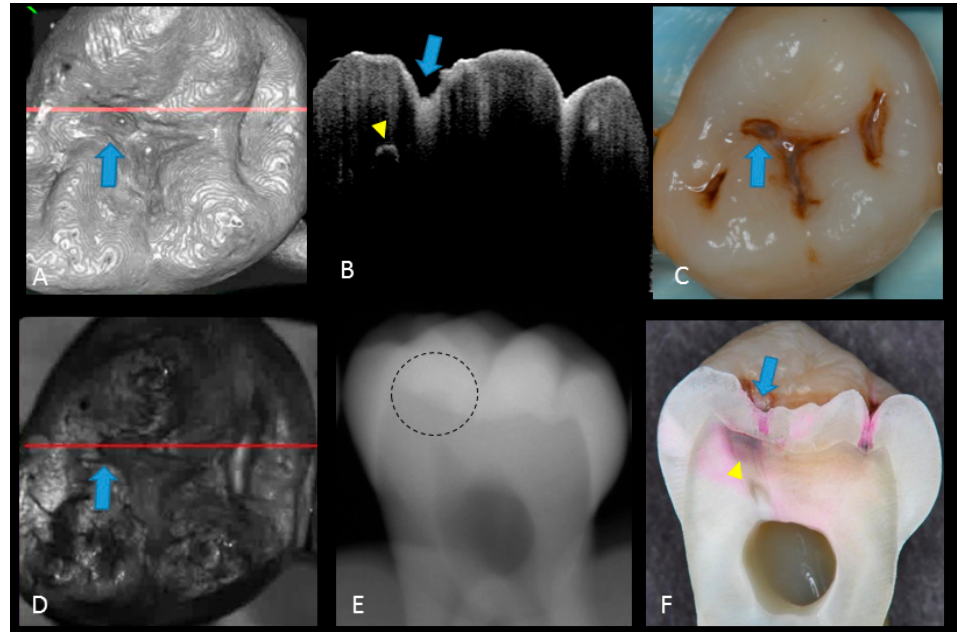
Figure 6. Dentin caries: ( A ) gray-scale three-dimensional (3D) OCT image; ( B ) cross-sectional OCT image of the lesion along the red line in (A) and (D). A separation of DEJ (triangle) was observed at the bottom at the lesion (arrow) indicating the lateral invasion of bacteria; ( C ) visual score 3 with visible dentin; ( D ) OCT en face intensity projection; ( E ) radiolucent lesion at DEJ; ( F ) cross-section view with penetration of dark red dye one-third of dentin thickness. The dynamic slicing 3D video is presented in Supplementary Materials: Video 4.